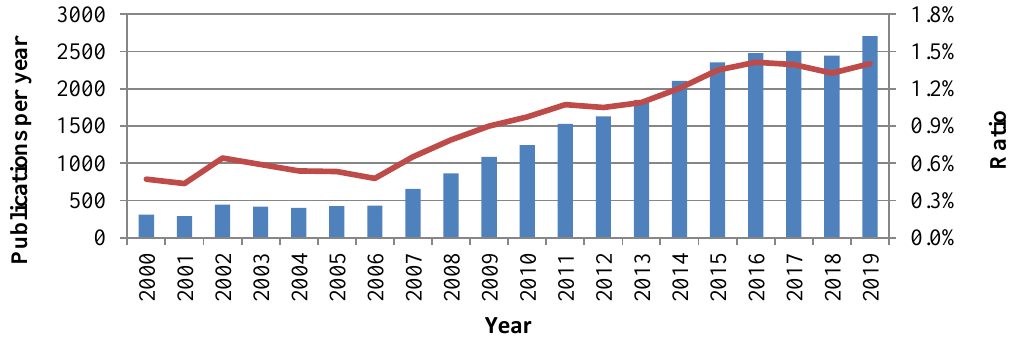
Figure 3. Publications per year (blue histogram) and ratio between publications in the Bioenergy topic and total publications in Agricultural and Biological Science field (red line).